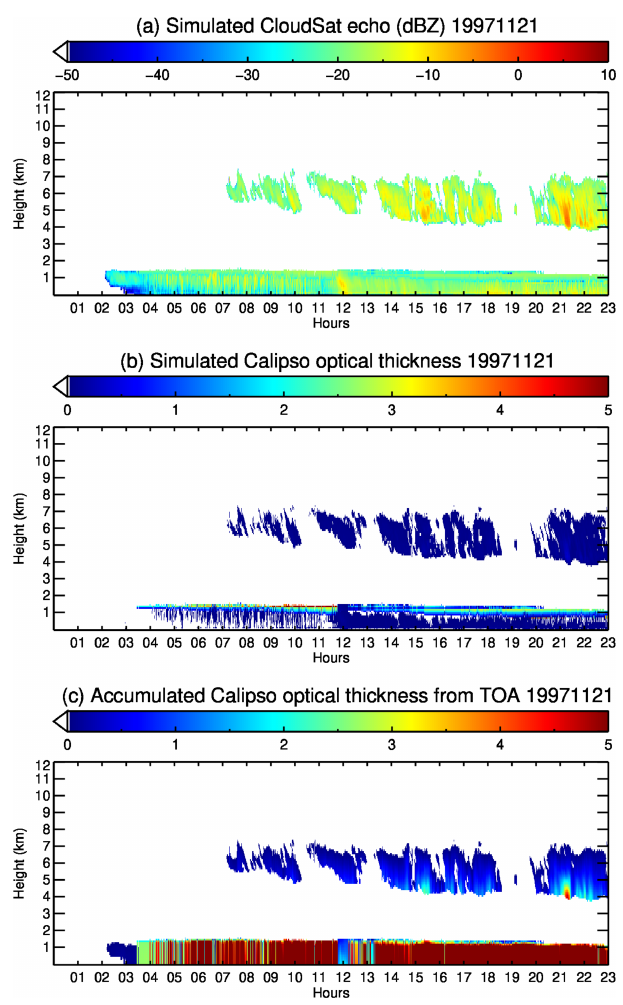
Figure 1. Simulated (a) CloudSat reflectivity and (b) CALIPSO cloud optical thickness, and (c) accumulated cloud optical thickness from the top of the atmosphere for CALIPSO on 21 November 1997 during the Surface Heat Budget of the Arctic Ocean (SHEBA) ex- periment.